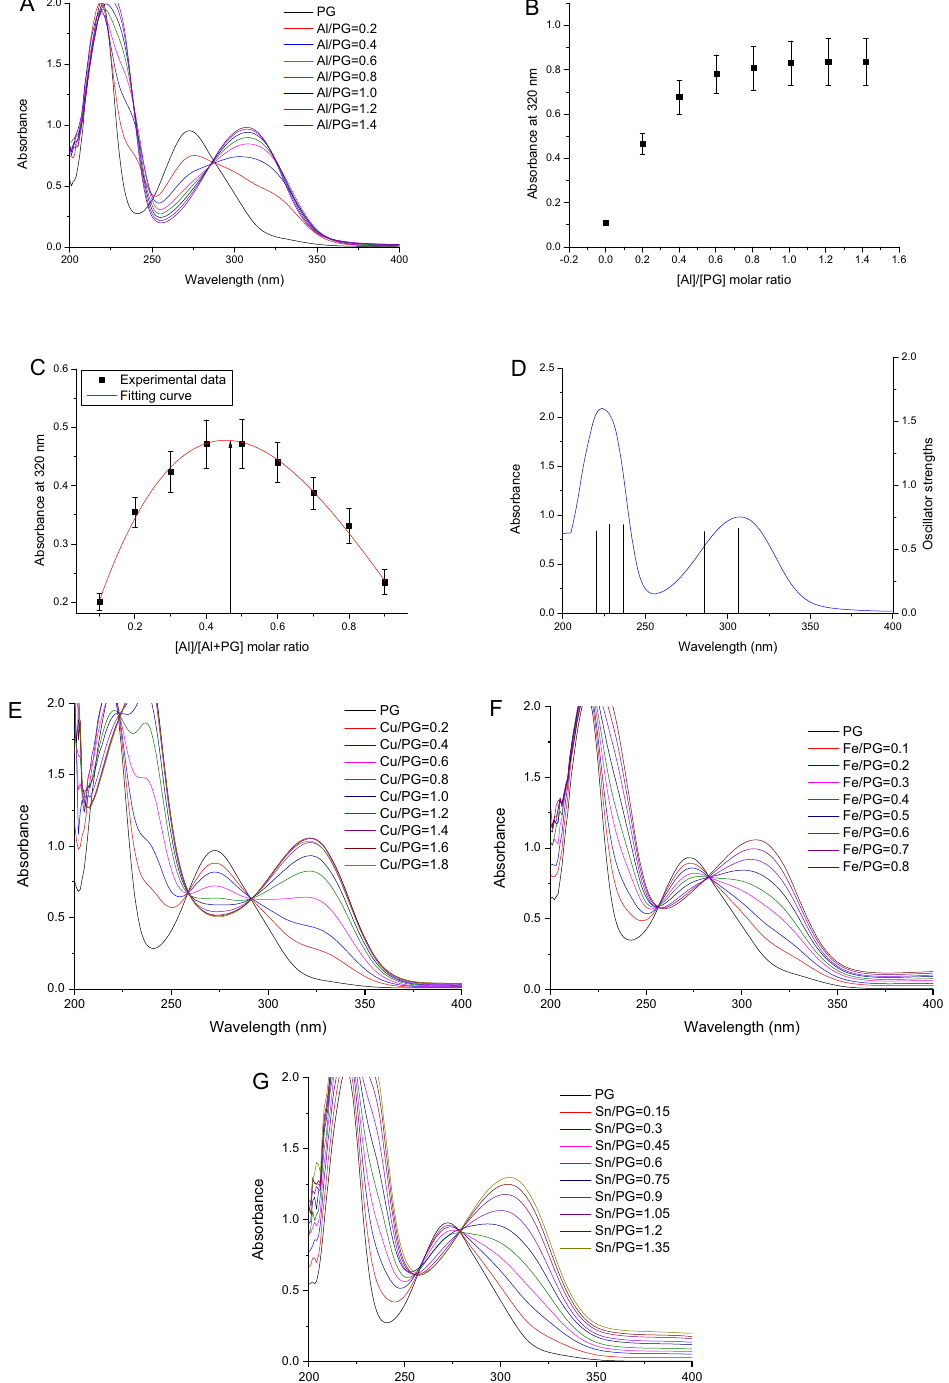
Figure 3. ( A ) UV–Vis spectra of 1 mL 100 µM PG titrated with 10 mM Al 3+ solution in 2 μL increment at pH 6 acetate buffers; ( B ) Changes of absorbance at 320 nm of PG binding Al 3+ in pH 6; (C) Experimental results of Job’s method studying Al 3+ and PG complexation at pH 6; ( D ) Computed transitions (vertical line) and experimental spectrum (curve) for free 1:1 PG-Al complex; ( E – G ) UV–Vis spectra of 1 mL 100 µM PG titrated with 10 mM Cu 2+ , 5 mM Fe 3+ or Sn 2+ solution in 2 or 3 μL increment at pH 6 acetate